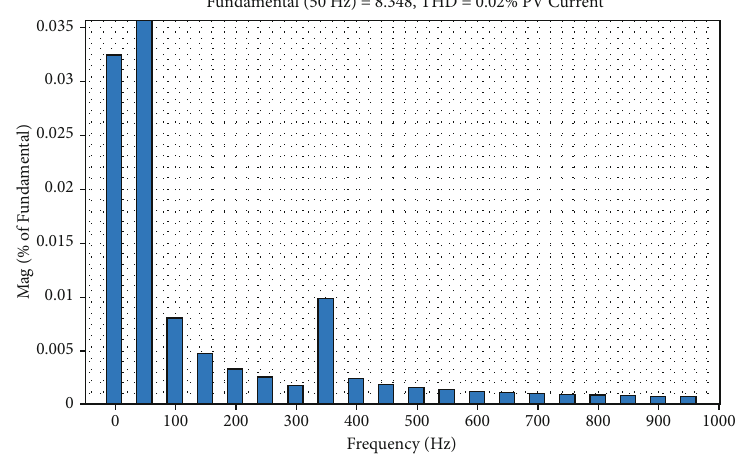
Figure 35: THD values of PV system current.